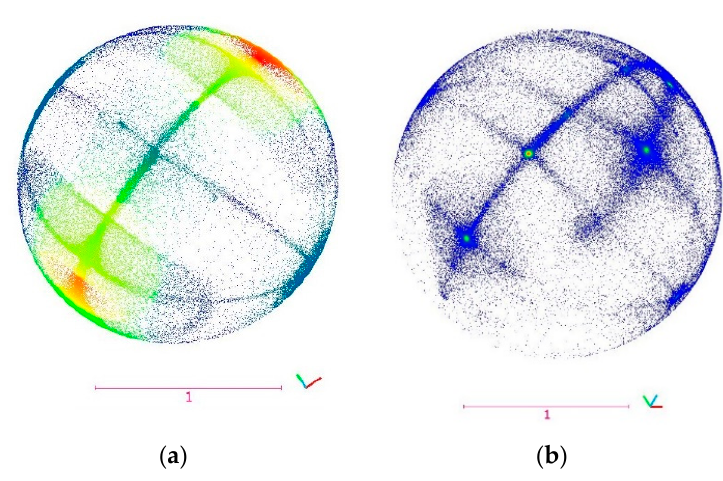
Figure 7. Segmentation in the feature space for R of ( a ) 0.5, ( b ) 0.015.